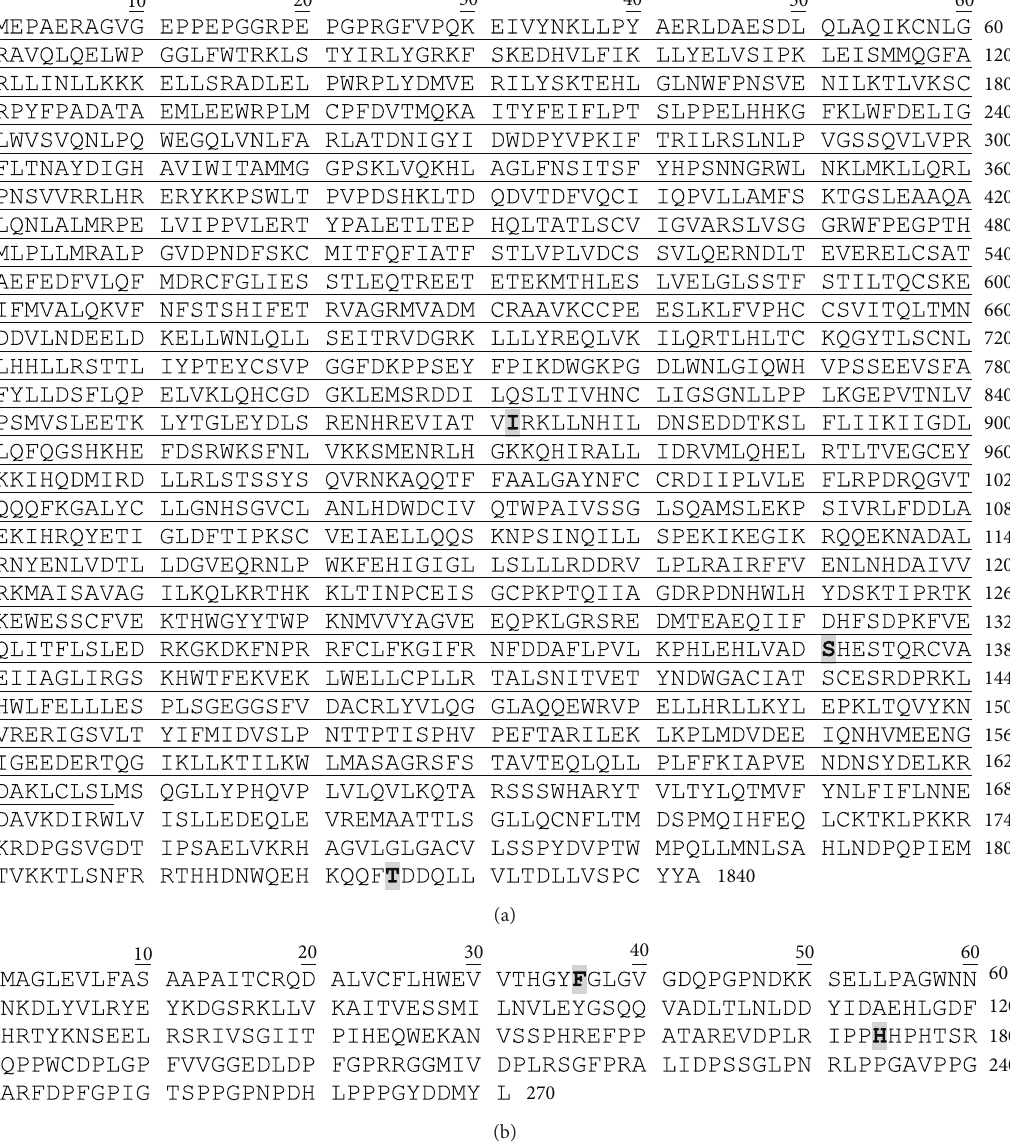
Figure 13: Sequences of human PSME4 and human PSMF1 subunits. Naturally occurring variants are highlighted with grey boxes. Alternatively spliced regions are underlined. Amino acid residue numbers are shown on the right of each sequence. UniProt accession numbers for PSME4 and PSMF1 are Q14997 and Q92530,